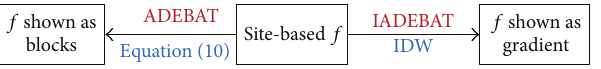
Figure 1: The sketch on difference between the ADEBAT model and the IADEBAT